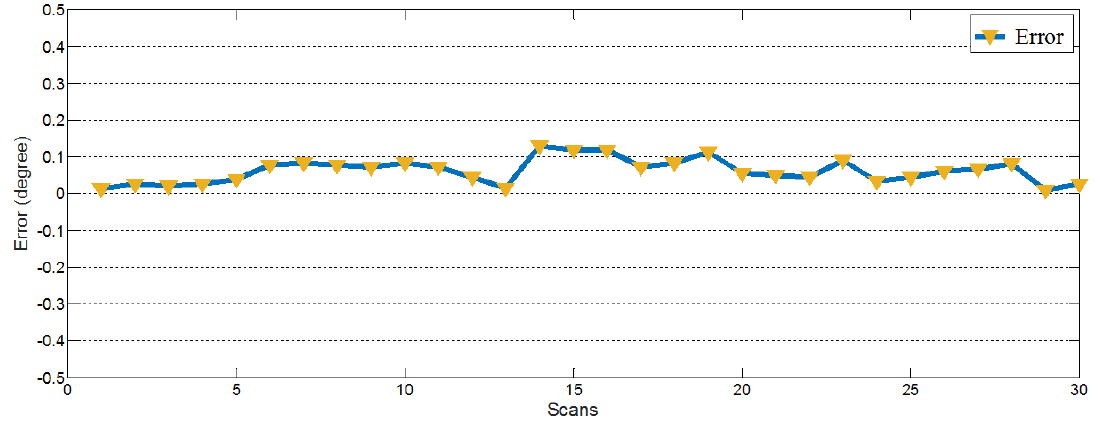
Figure 7. Absolute errors between the calculated adding bias angle and the setting angle. The error varies in a small range.